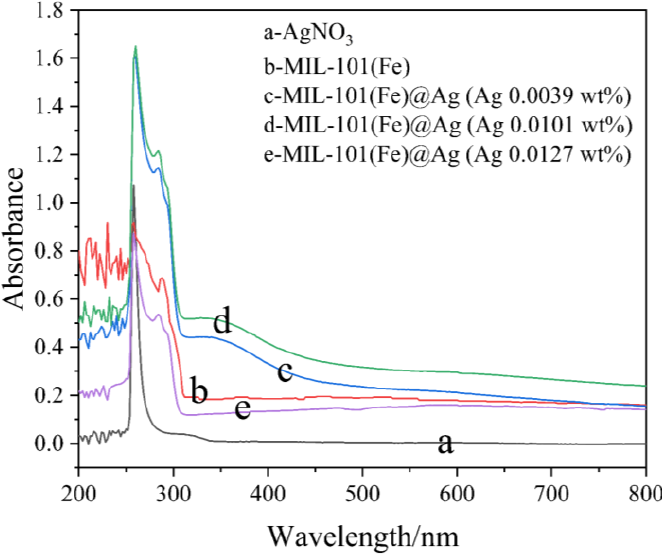
Figure 5. UV–vis spectra of AgNO 3 , MIL-101(Fe), and MIL-101(Fe)@Ag. Figure 5. UV – vis spectra of AgNO 3 , MIL-101(Fe), and MIL-101(Fe)@Ag.